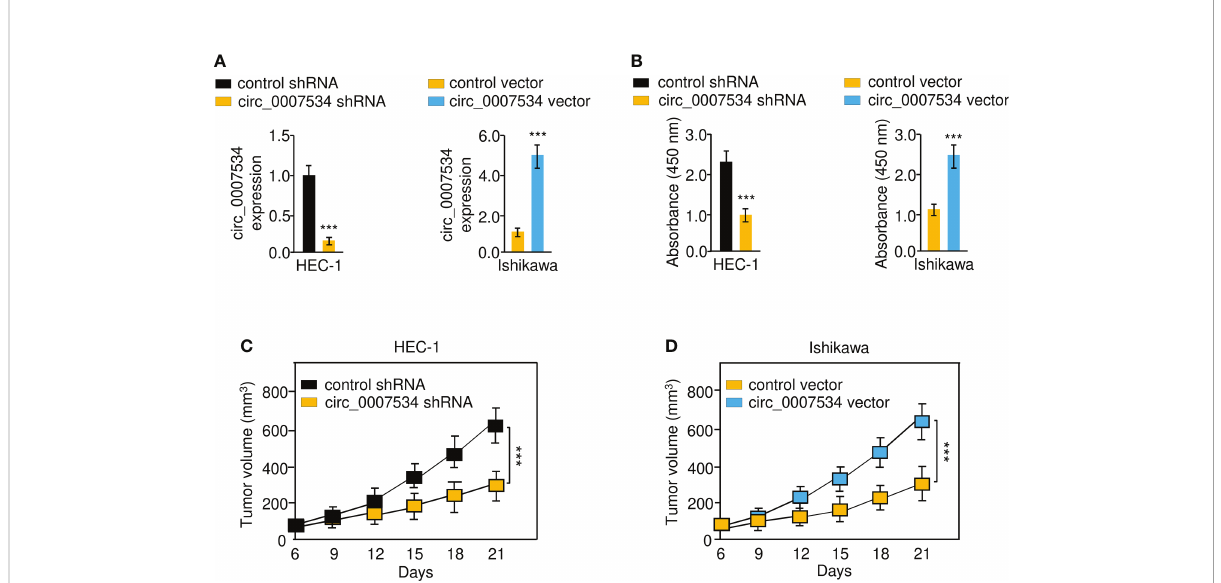
FIGURE 2 Circ_0007534 promotes the proliferation of endometrial cancer cells. (A) The expression of circ_0007534 in HEC-1 cells that were transfected with circ_0007534 shRNA or control shRNA (left) and in Ishikawa cells that were transfected with circ_0007534 vector or control vector (right). (B) The proliferation of the indicated cells was determined with the CCK-8 assay. (C, D) Effects of circ_0007534 knockdown or overexpression on xenograft HEC-1 (C) and Ishikawa (D) cell growth in vivo . *** P <